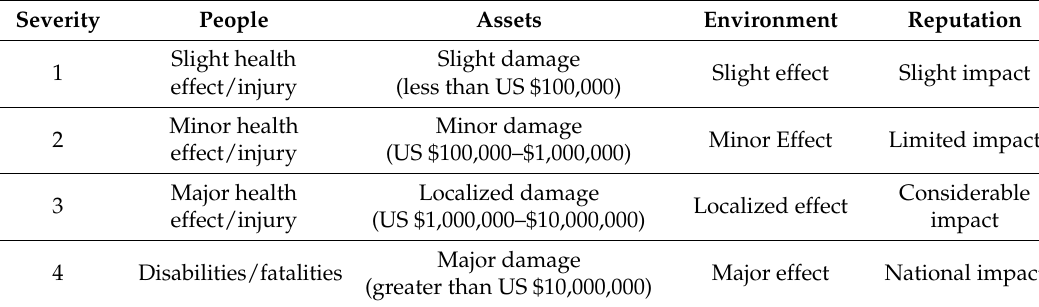
Table 3. Severity assessment.